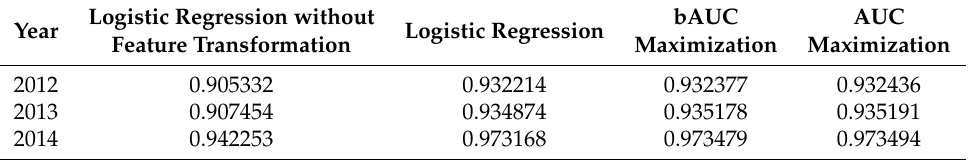
Table 3. Results for models with two features—DTI and Employment Length.